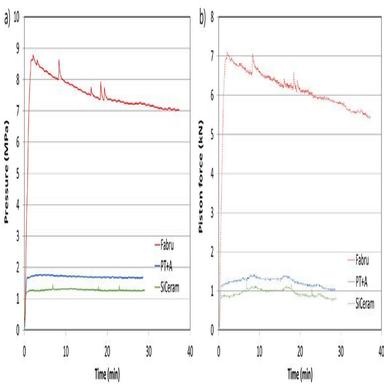
Homogeneity analysis at 150 ◦C of the three different YSZ filaments (SiCeram, PT+A, and Fabru) using E3D V6 nozzle with a diameter of 0.25 mm and a shear rate of 6′ 000 s -1− 1 ; a) shows the pressure at the die entrance vs. time and b) shows the piston force vs. time.